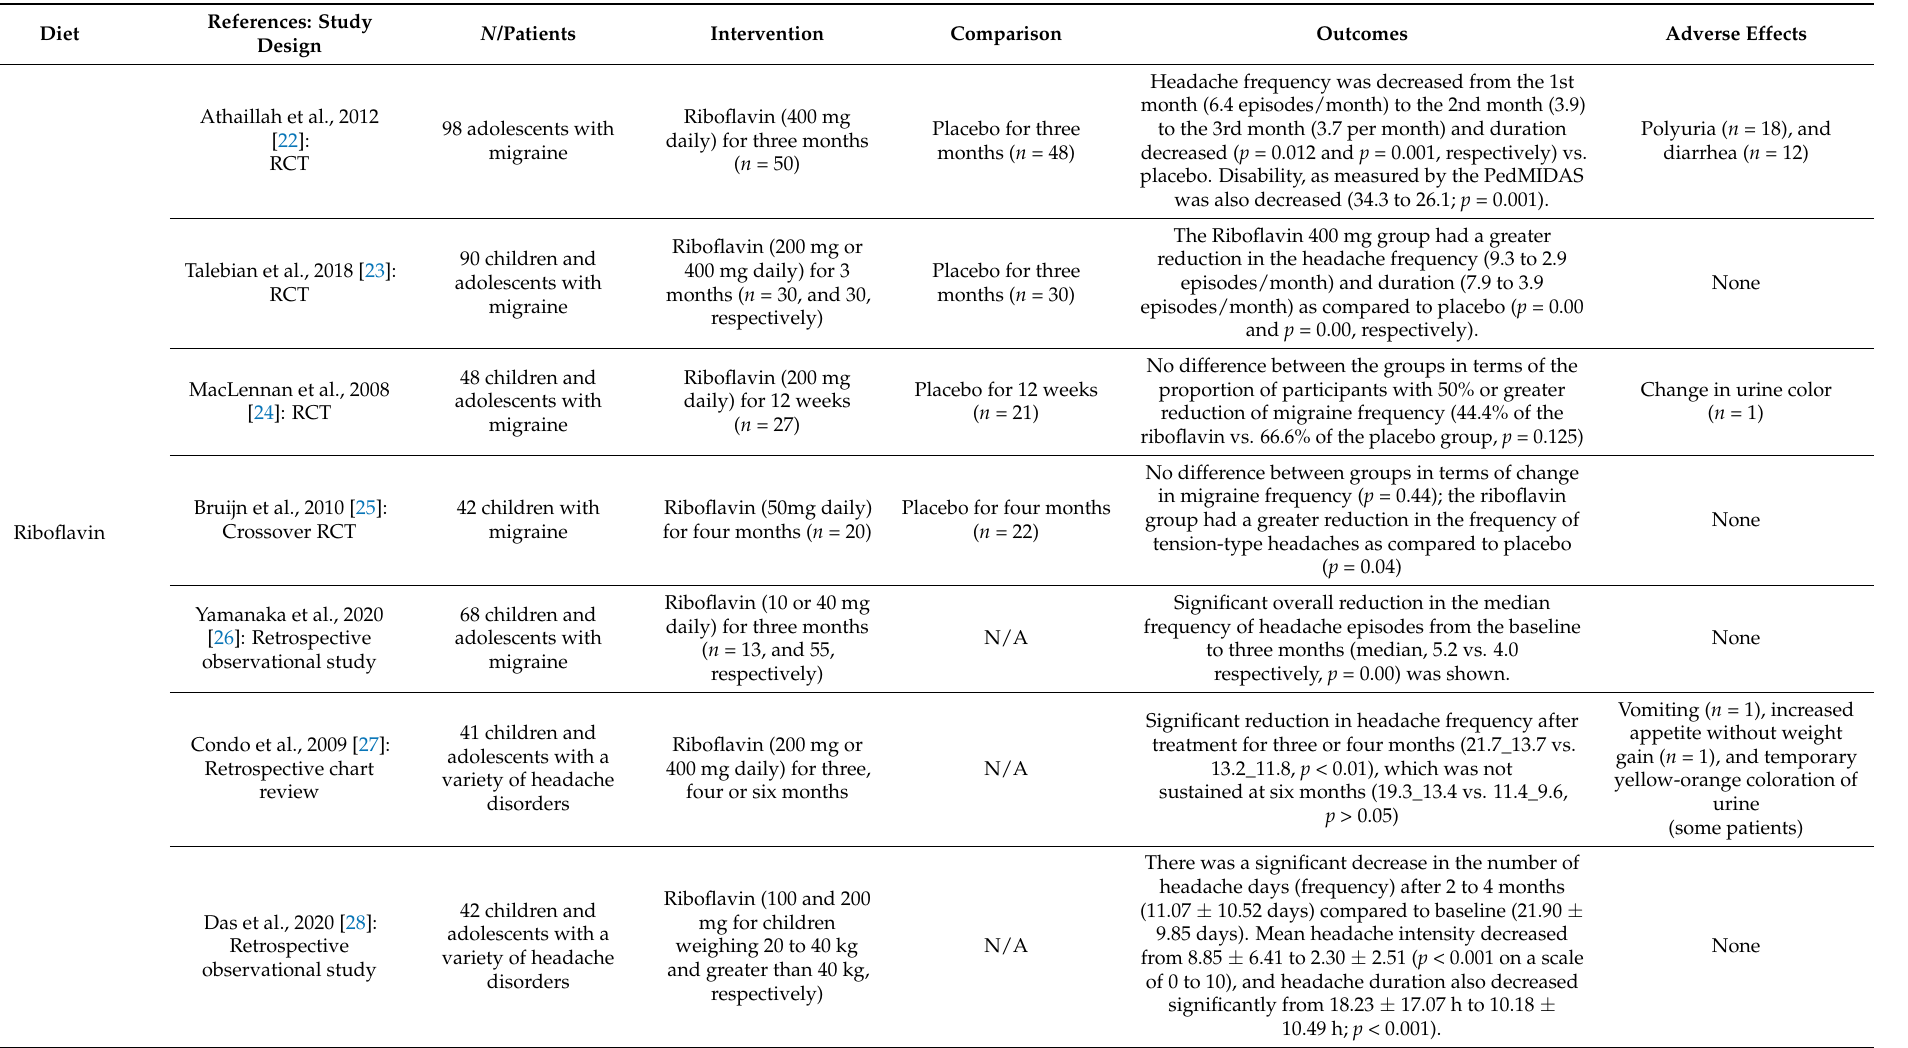
Table 1. Summary of studies on complementary and integrative medicines for pediatric